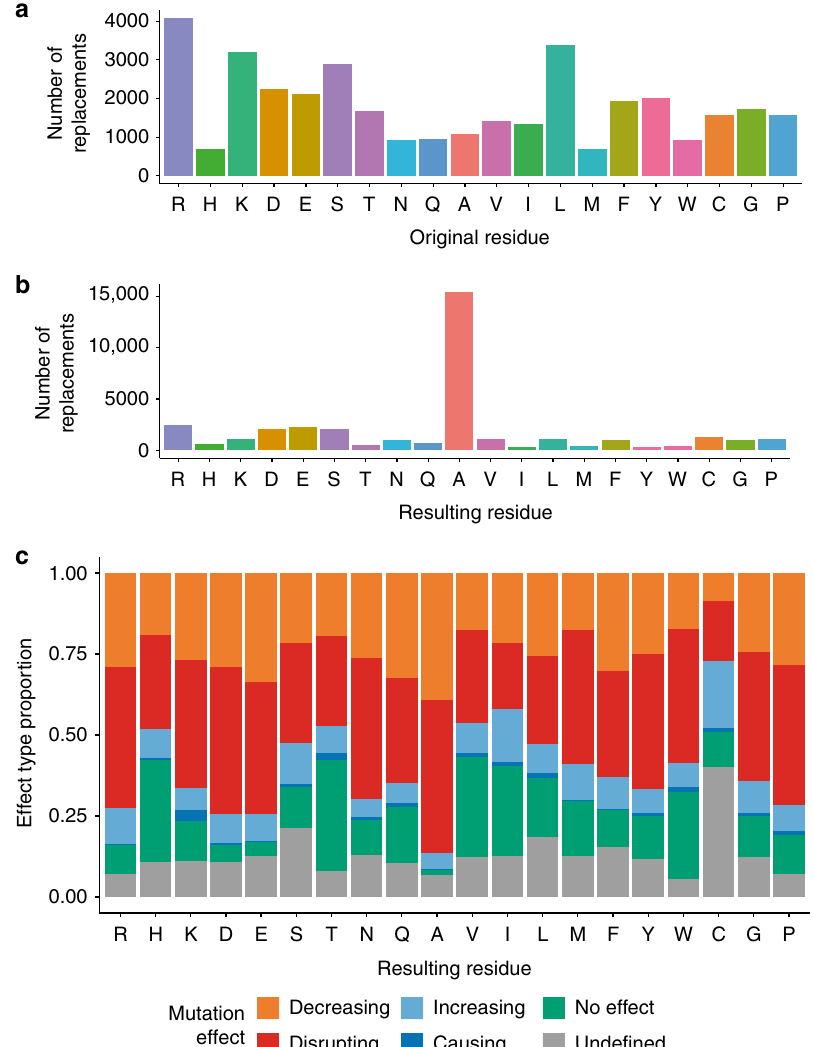
Fig. 2 Amino acid replacement frequencies in the full data set. a Replacement frequencies by original residue; b Replacement frequencies by resulting residue; c Normalized frequencies of resulting sequences by mutation effect over the interaction. Substitutions with non-standard amino acids and deletions are not shown for simplicity. Source data are provided as a Source Data fi